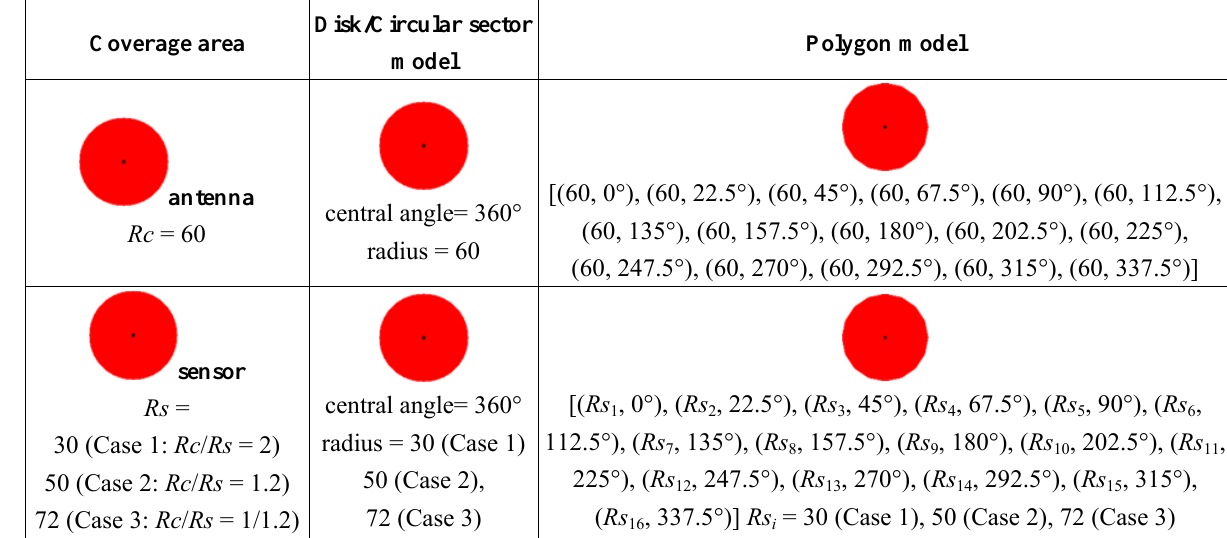
Table 2. The coverage areas of omnidirectional antenna/sensor under different models.